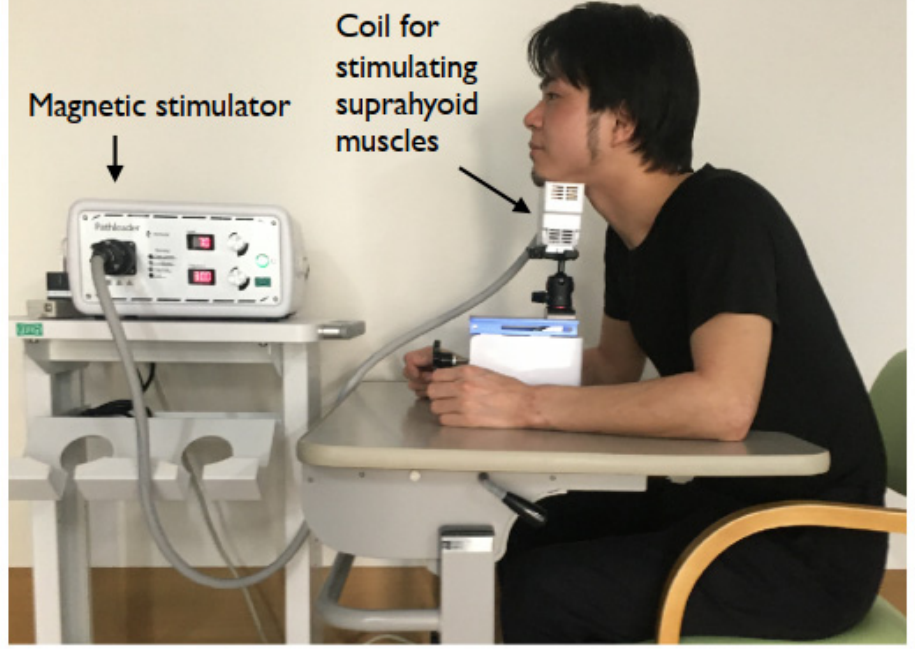
Figure 7. Repetitive peripheral magnetic stimulation system (Pathleader™). The smaller coil was developed to stimulate suprahyoid muscles.